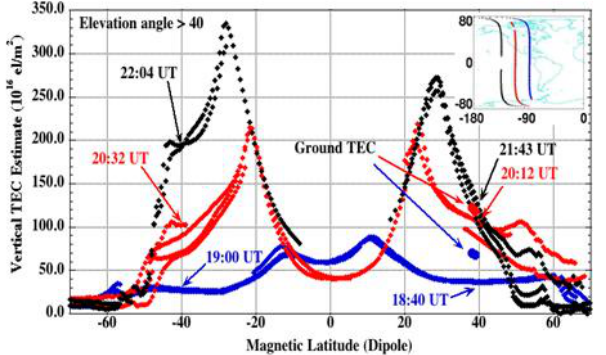
Fig. 1. Three passes of the CHAMP satellite through the dayside ionosphere at ~1230 to 1330 MLT. CHAMP was at an altitude of ~400 km. The blue curve was taken prior to the 30 October 2003 magnetic storm. The red curve was taken at the beginning of the storm, and the black near the end of the storm. The figure is taken from Mannucci et al. (2005), Figure 3.